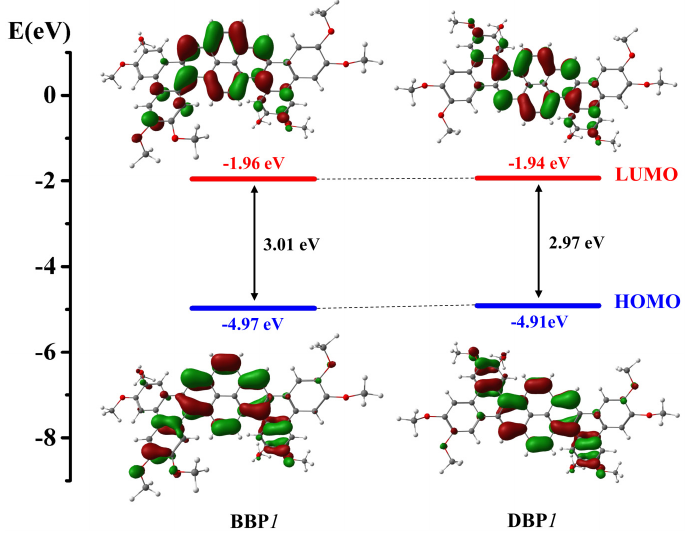
Figure 8. Comparison of HOMO–LUMO energy levels of BBP 1 and DBP 1 (isovalues = 0.02), as models for compounds BBP n and DBP n , respectively.